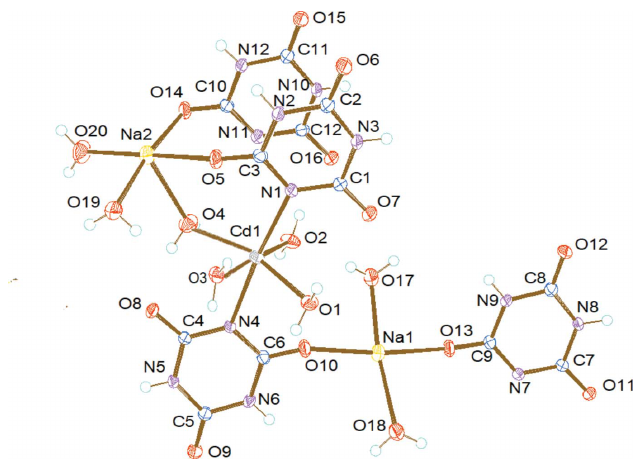
Figure 1 The asymmetric unit of the title compound with displacement ellipsoids drawn at the 50% probability level.